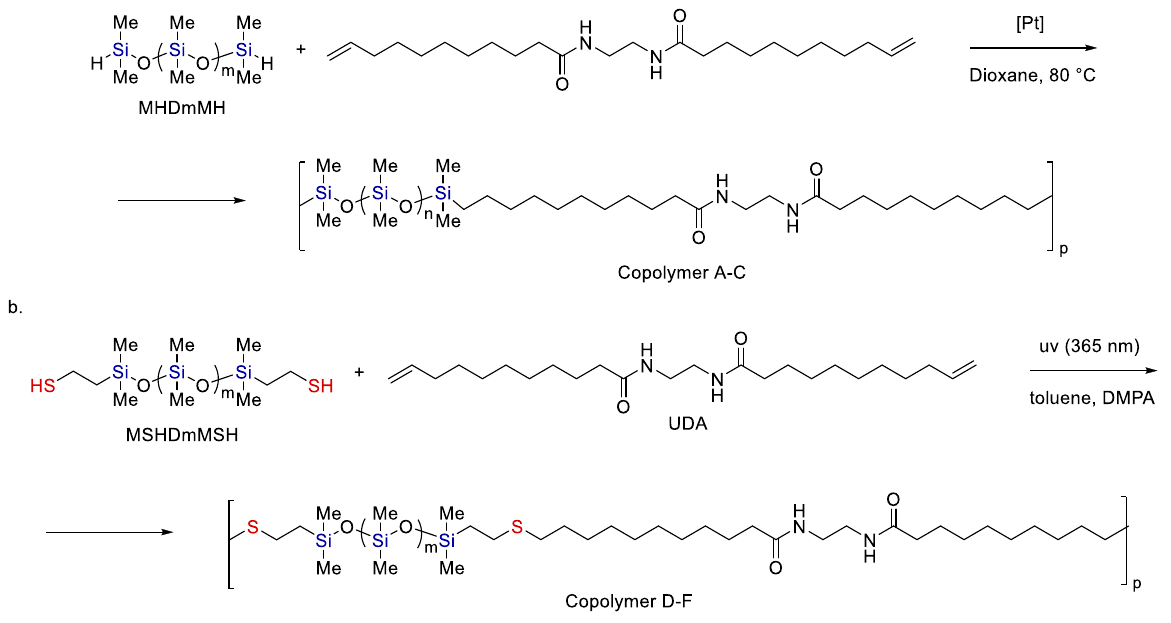
Figure 28. The synthesis of siloxane-containing copolymers based on undecenoic acid diamide by hydrosilylation ( a ) and hydrothiolation ( b ) [126]. Adopted from Ref.